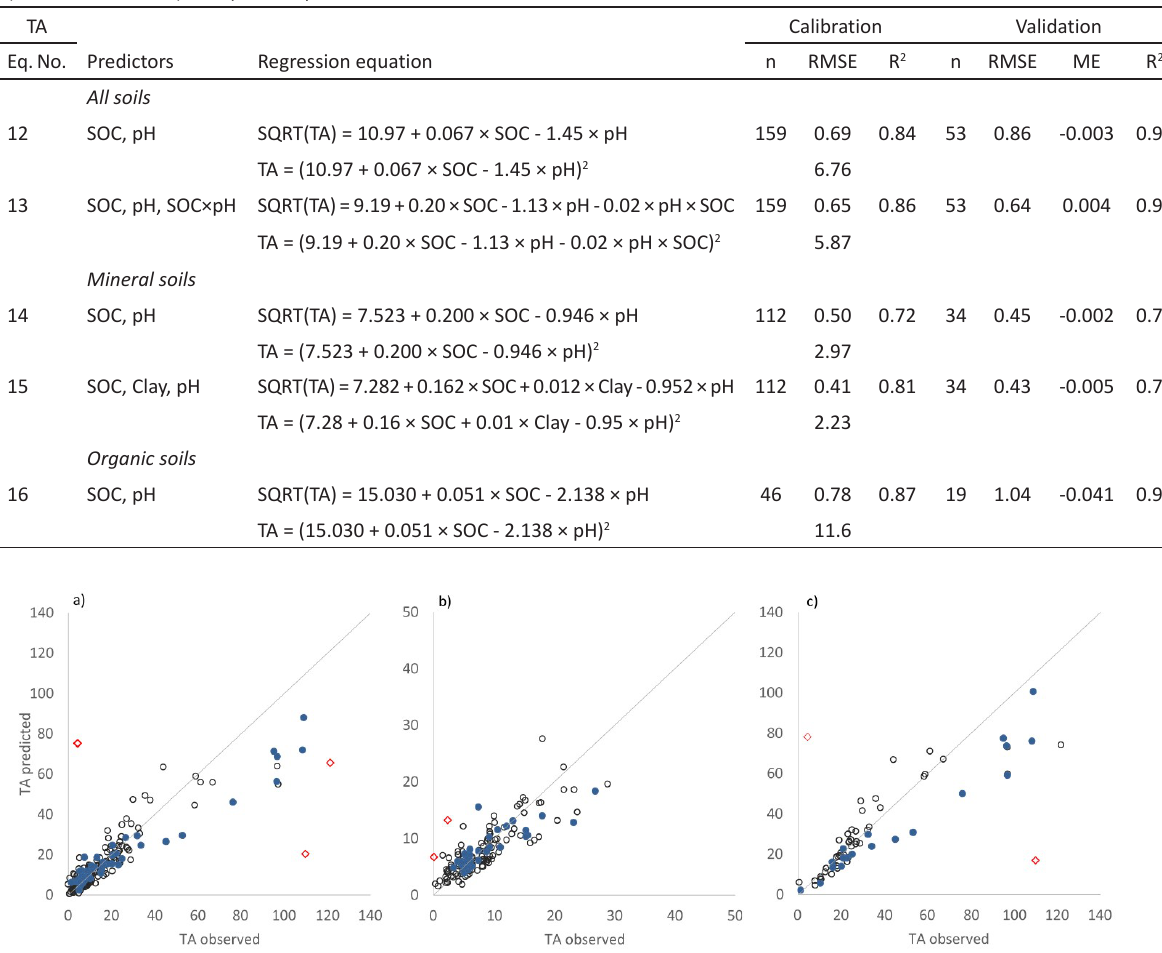
Fig. 4. Predicted titratable acidity (TA, cmol(+) kg -1 ) modelled using pH and soil organic carbon (SOC, %) as predictors for a) whole data, b) for mineral soils and c) for organic soils plotted against observed TA (cmol(+) kg -1 ). Open circles represent the results of the calibration data and blue circles represent the validation data. Data points excluded from the regression analysis as outliers are marked with red